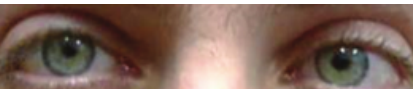
Figure 3: This photo was taken several seconds after testing for near accommodation. The right pupil had a normal constriction phase but later demonstrated a slower dilation response then the left pupil. Thisanisocoriaisaresultofarighttonicpupilduetociliaryganglion